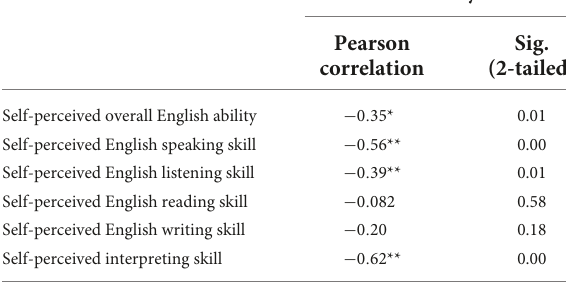
TABLE 7 Pearson product–moment correlation between interpretation classroom foreign language anxiety levels and self-perceived language